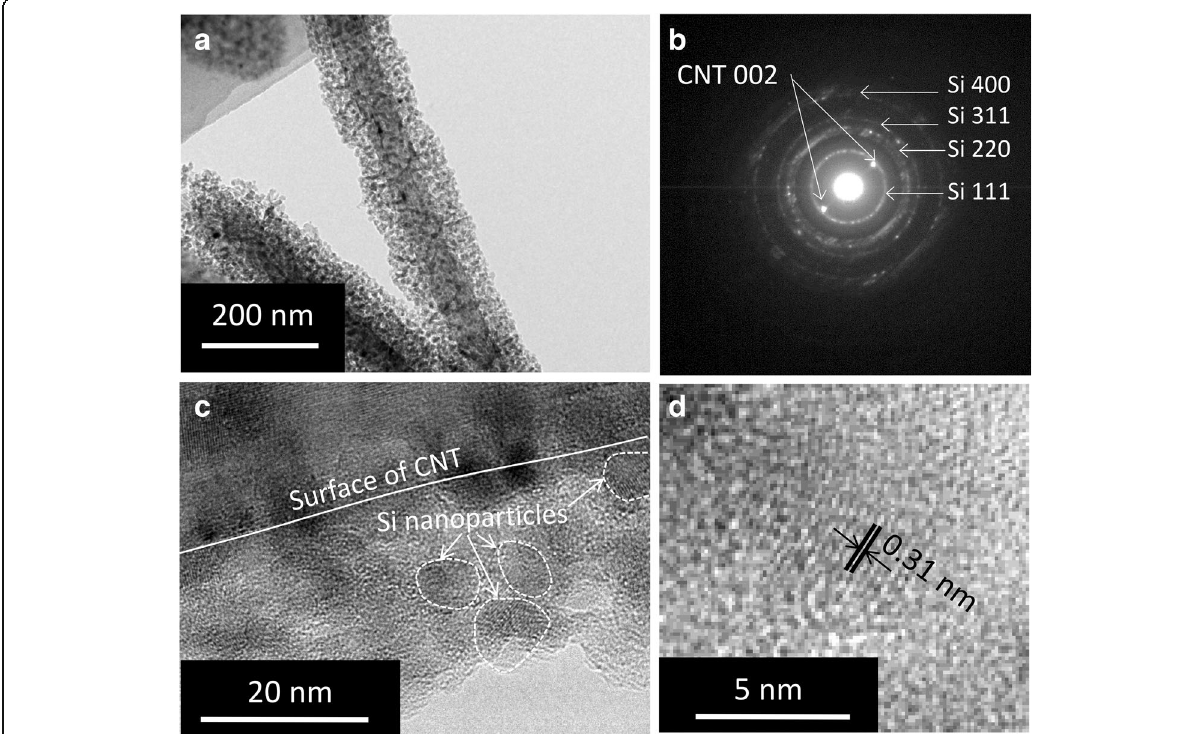
Fig. 3 a TEM image of Si-coated CNTs. b SAED pattern of Si-coated CNTs. c Interface between CNT and silicon layer. d High magnification image of Si